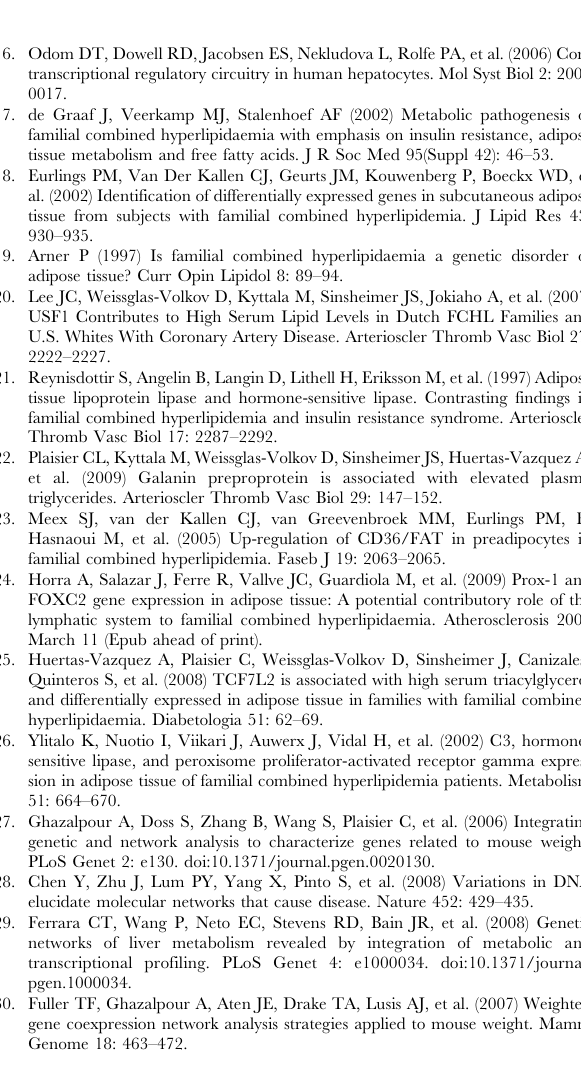
Table S5 Functionally enriched annotation terms for the set of genes comprising each co-expression module (Benjamini-Hoch- berg corrected p-value # 0.05). Table S6 Trait variance explained by WGCNA co-expression module eigengenes (Adjusted R 2 ).